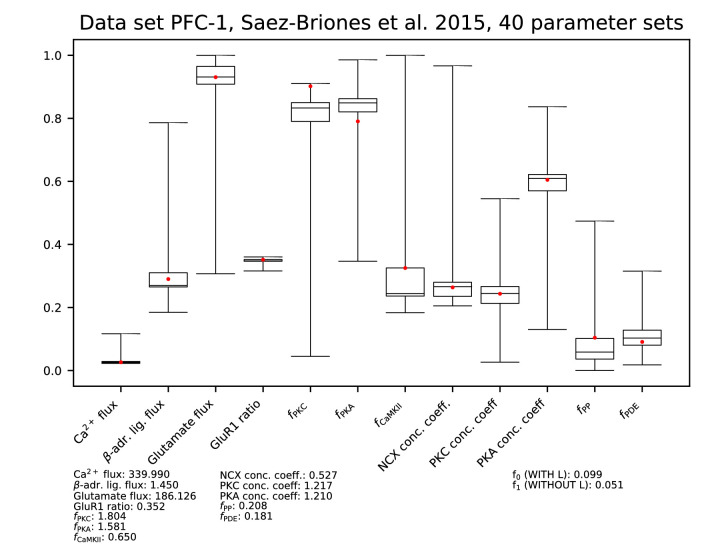
Parameters for data set PFC-1.See Figure 9—figure supplement 1 for details.